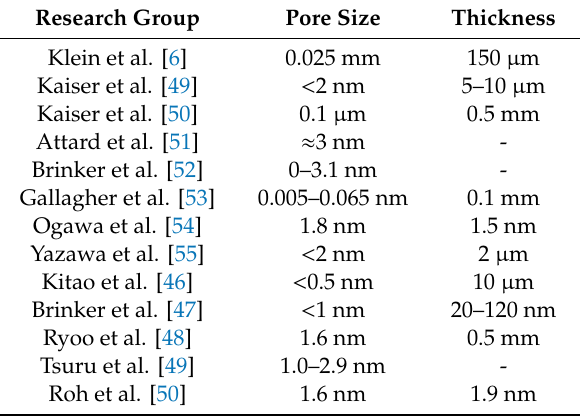
Figure 4. ( a ) Reflected light micrograph of top-side of a 2 month dried sample, adapted from [6], with permission from Copyright (1988), Elsevier Science Publishers. ( b , c ) Transmission electron micrographs of ordered mesoporous silica post calcination, adapted from [48] with permission from Copyright (1997), American Chemical Society. Table 1. Specifications of silica membranes fabricated in some of the early studies aimed for pervaporation based applications.